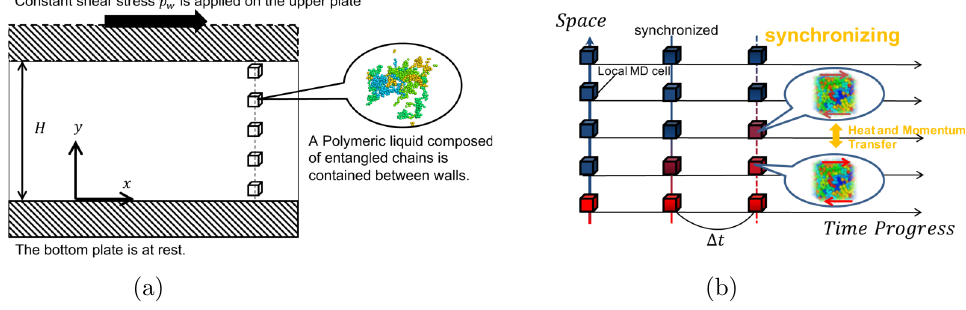
Figure 1. Schematics of ( a ) the geometry of the problem and ( b ) the time schedule scheme of synchronized molecular dynamics